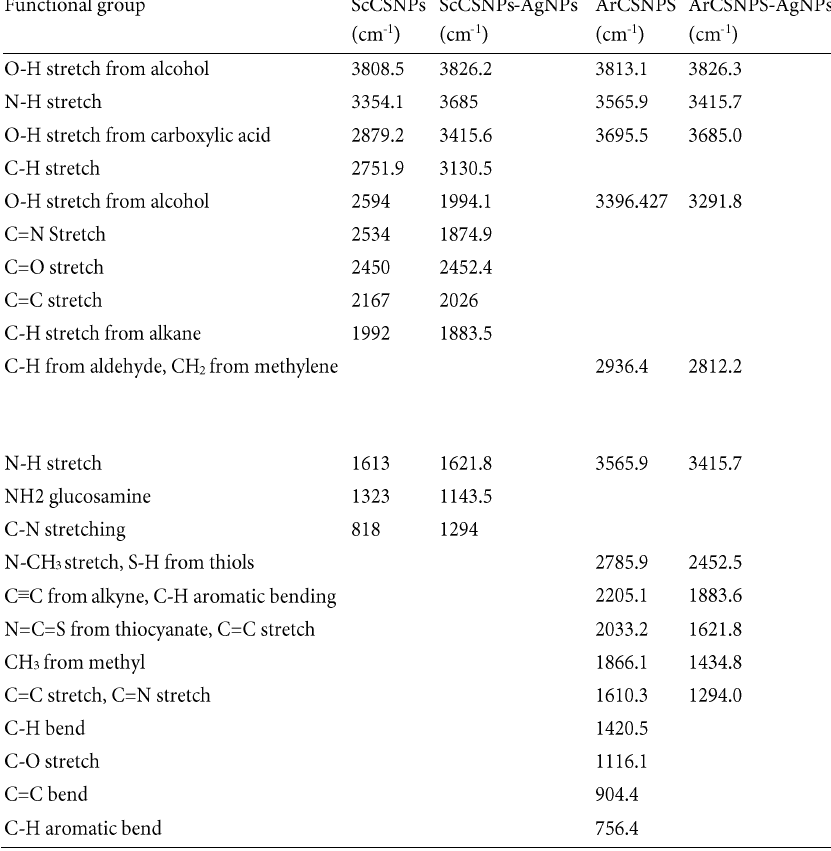
Table 1: Functional groups associated with corresponding peak